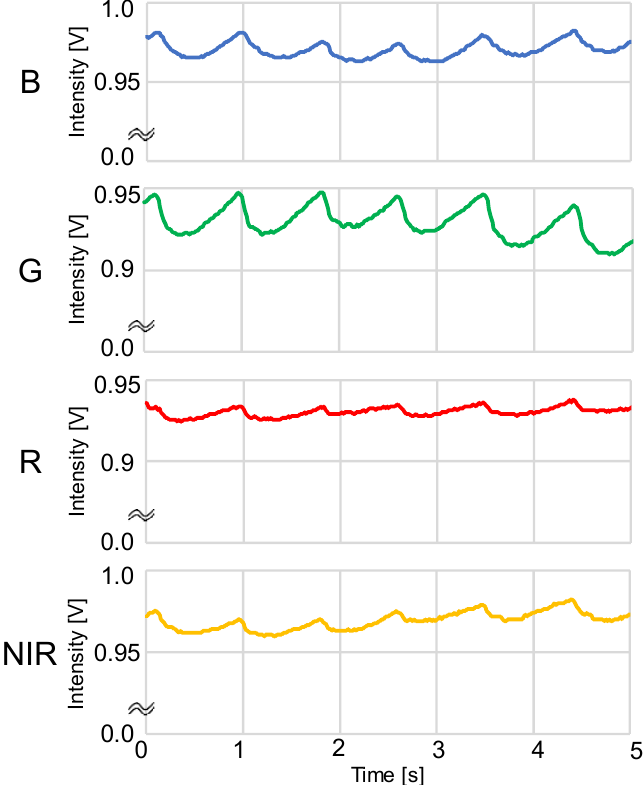
Figure 2. Example of simultaneous recordings of blue, green, red, and near-infrared light photoplethysmograms (PPGs) measured using a DC amp: B = blue LED PPG, G = green LED PPG, R = red LED PPG, and NIR = near-infrared LED PPG.